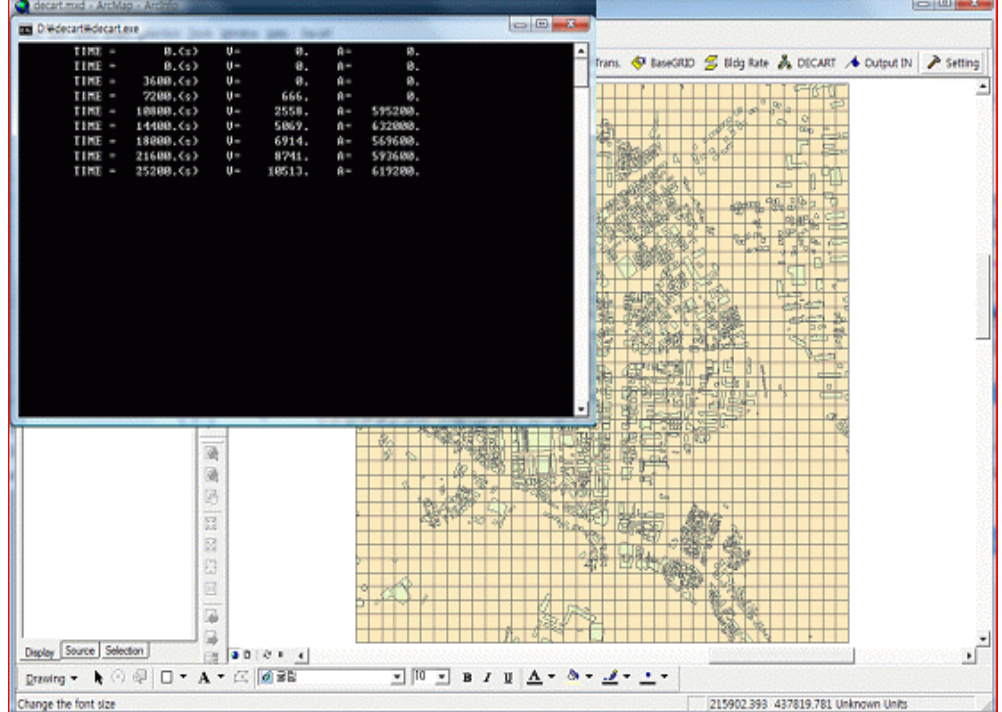
Fig. 8. Calculating inundation depth on ArcGIS.